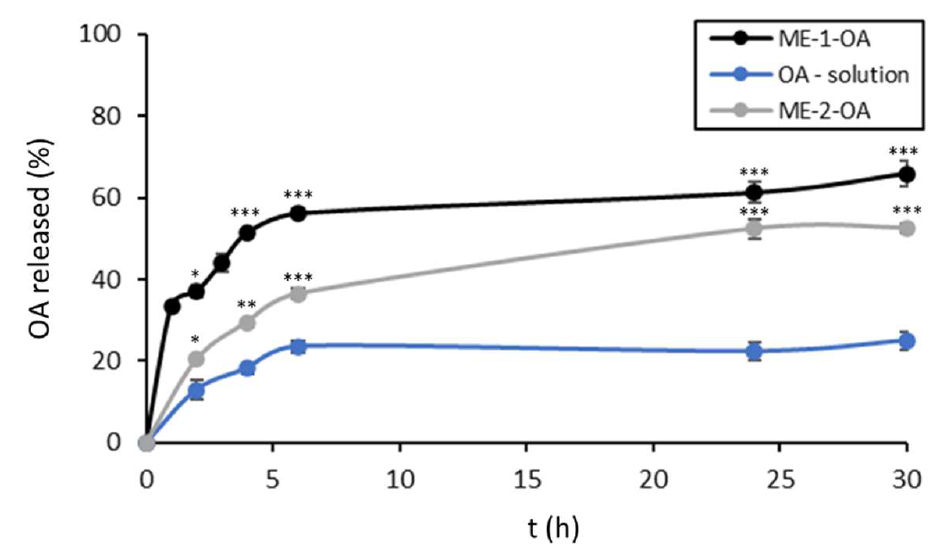
Figure 5. In vitro release profiles of OA from solution, ME-1-OA and ME-2-OA in EtOH:PBS (30:70). Values are reported as mean ± SD of three independent experiments. Tukey’s test ( n = 3): * p < 0.05, ** p < 0.01, *** p < 0.001 vs. OA-solution at the corresponding times. Table 4. Regression coefficient (R 2 ) obtained in different kinetics models for OA release from ME-1- OA and